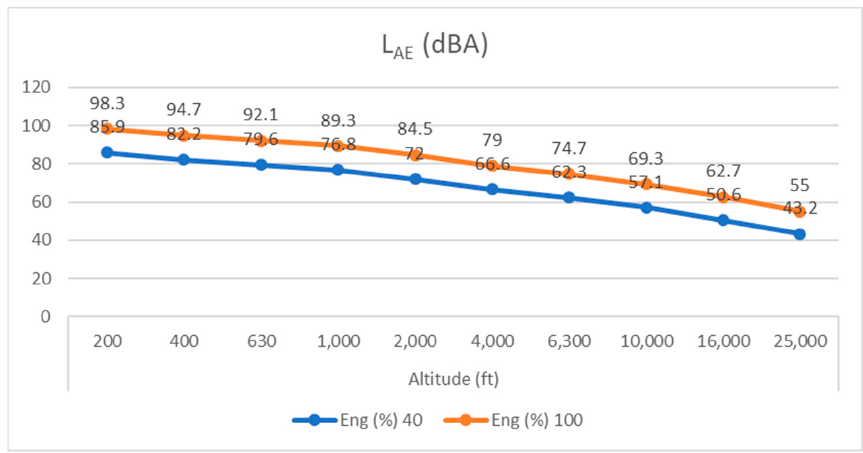
Figure 34. NPD curves, in terms of L AE , for the DEP configuration.